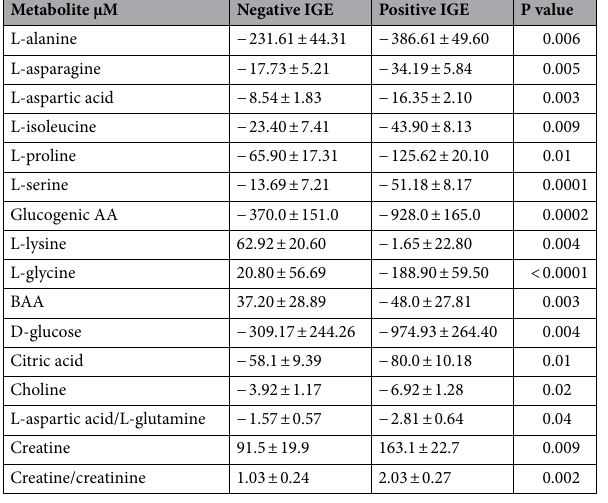
Table 1. Least squared means and SE of the magnitude of change (delta) of metabolite concentrations of pigs that have an estimated relative positive genetic effect or negative genetic effect (IGE) on the growth of their pen mates after regrouping at 9 weeks of